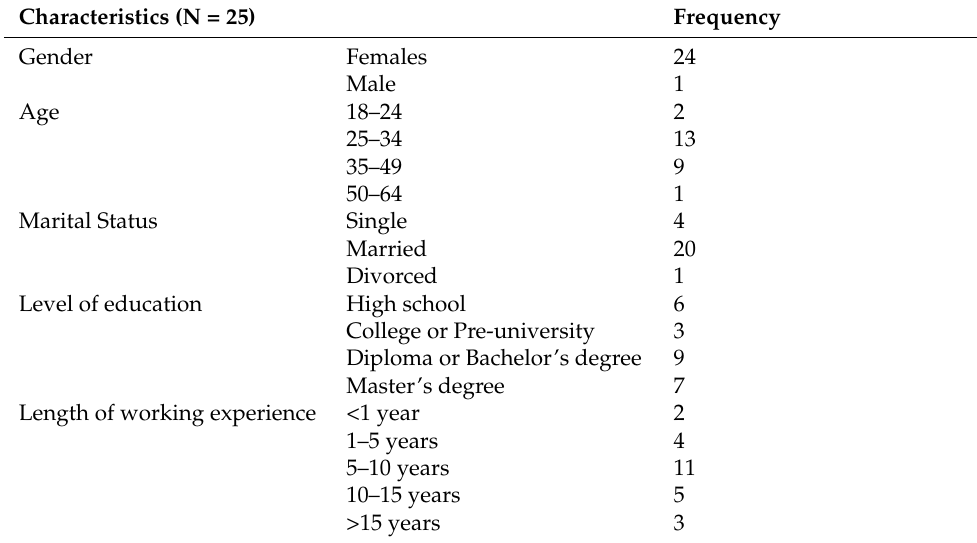
Table 3. Demographic characteristic of